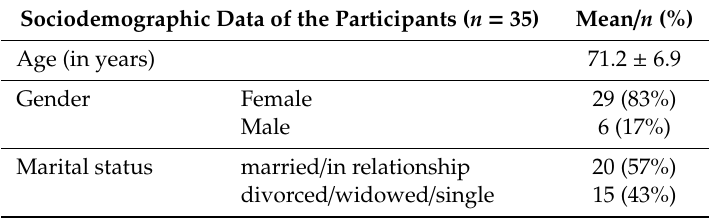
Table 1. Sociodemographic data of the participants ( n =